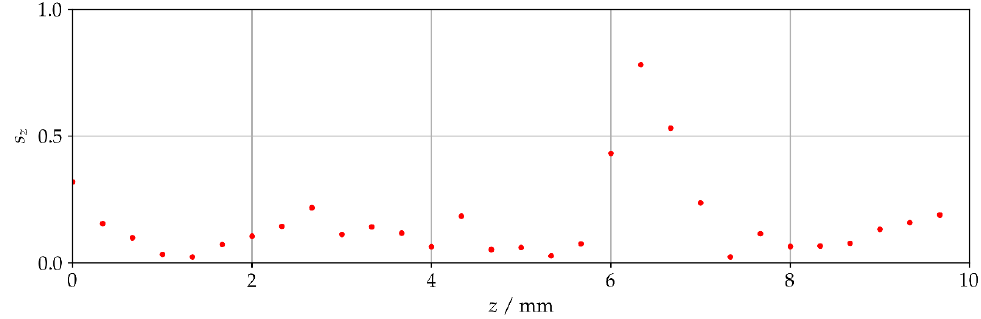
Figure 3. Phase smoothness 𝑠 𝑧 at different reconstruction distances 𝑧 for a gear sample. A maximum around 6 mm can be found, corresponding to the in-focus distance.